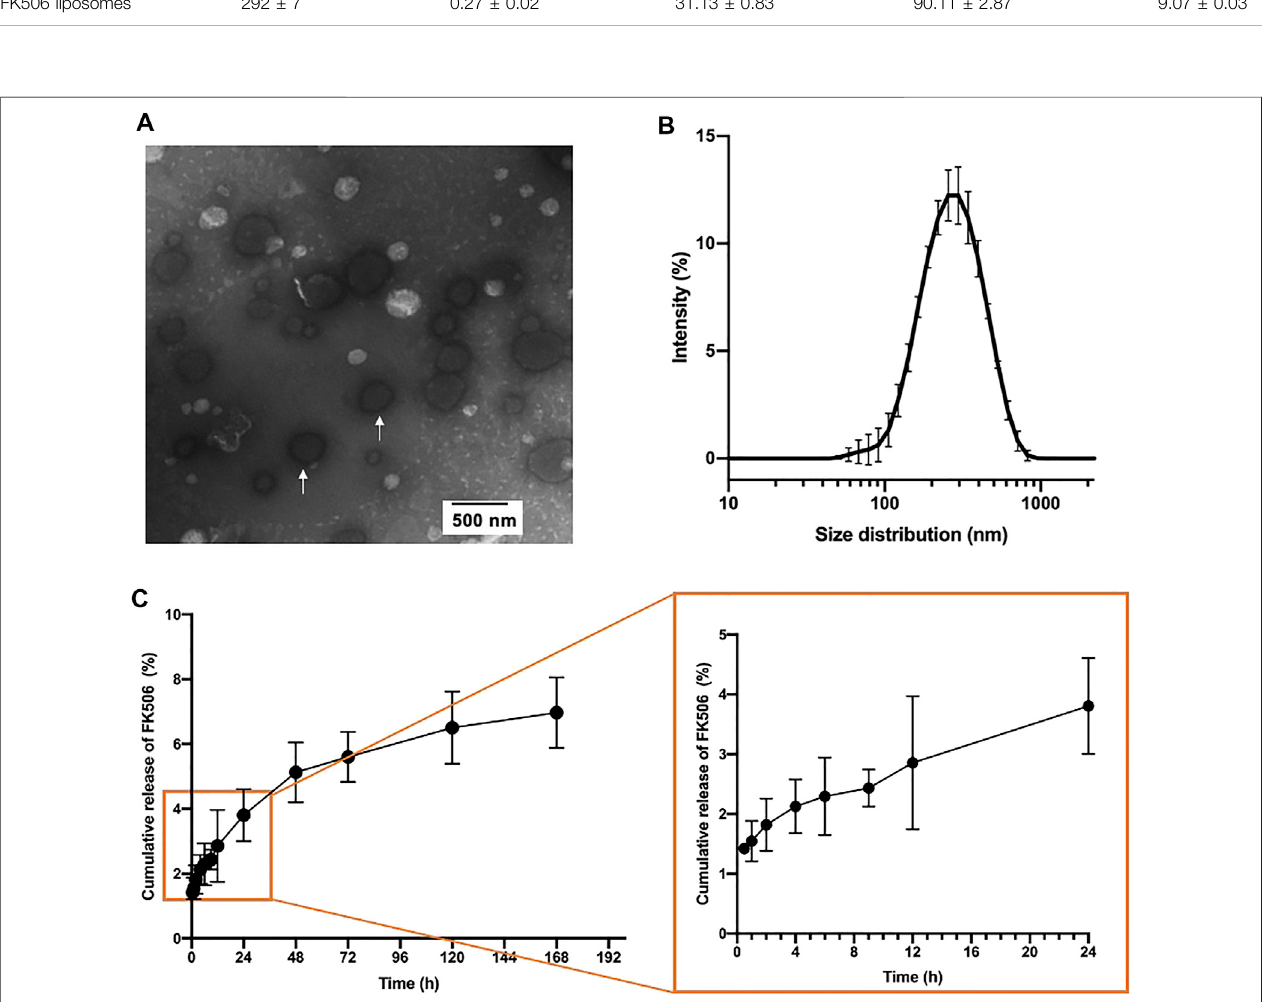
FIGURE 1 | Physicochemical properties of FK506 liposomes. (A) Representative TEM image of FK506 liposomes (white arrow). (B) Size distribution of FK506 liposomes in PBS. ( n = 3). (C) FK506 release pro fi le in vitro in 7 days (right) and partial enlarged image (right). ( n = 4).